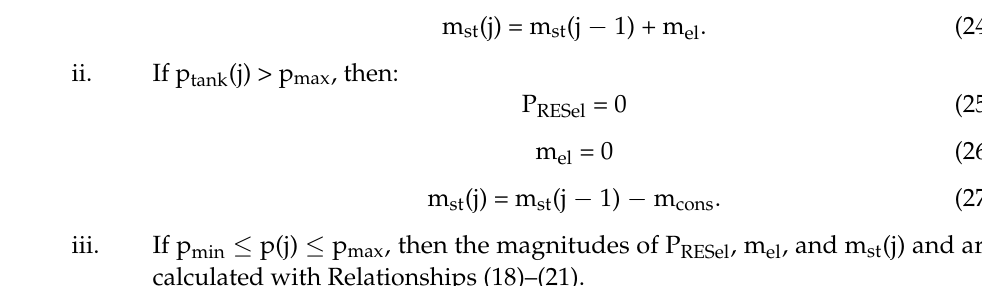
Figure 17. Annual pressure fluctuation in the hydrogen storage tank. It is conceivable that the potential hydrogen production from the hybrid power plant’s electricity surplus is capable of fueling the regular, daily, cheap, secure and sus- tainable maritime connection between Sifnos and the most important nearby insular cen- ters of the Cyclades Prefecture. Another important contribution from the hybrid plant is the remedying of the major problem regarding potable water availability, which is common for all small islands in Greece. Assuming an electricity-specific consumption of 4 kWh/m 3 in the reverse osmosis desalination process, 1,250,000 m 3 of potable water can be produced annually by exploit- ing 5000 MWh from the annual electricity surplus. This amount is roughly two times higher than the current annual potable water consumption on the island. This increasing